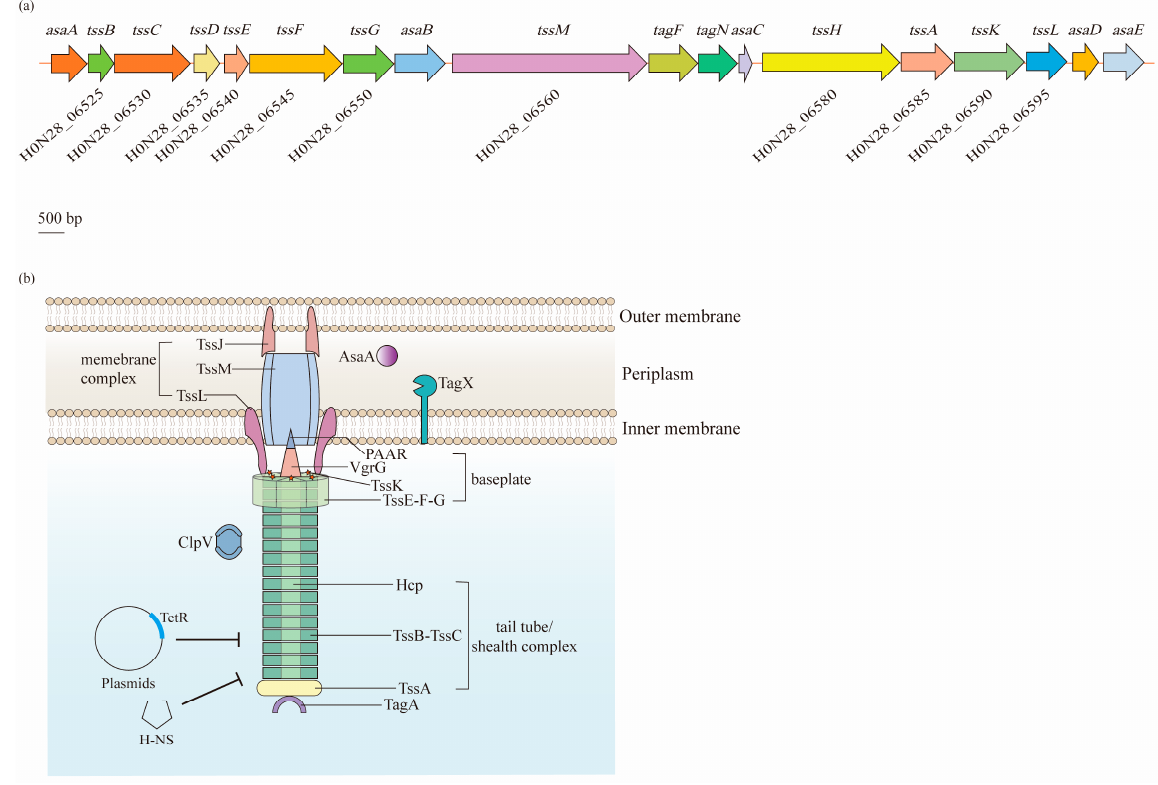
Figure 5. Biogenesis and regulation of the type VI secretion system (T6SS) in A. baumannii . The T6SS is a class of macromolecular secretion machines, which translocate proteins into a variety of recipient cells: ( a ) A single gene cluster carries 18 putative genes that are predicted to encode components of the T6SS. Among them, 12 core genes ( tss ) are coded on the chromosome of A. baumannii ATCC 17978. ( b ) The T6SS is composed of three main parts: a membrane complex (TssJ, TssL, and TssM), a cytoplasmic baseplate (TssK, TssF, TssG, TssE, VgrG, and PAAR), and a contractile tail tube/sheath complex (Hcp, TssB, TssC, and TssA). The expression of the T6SS is negatively regulated by the